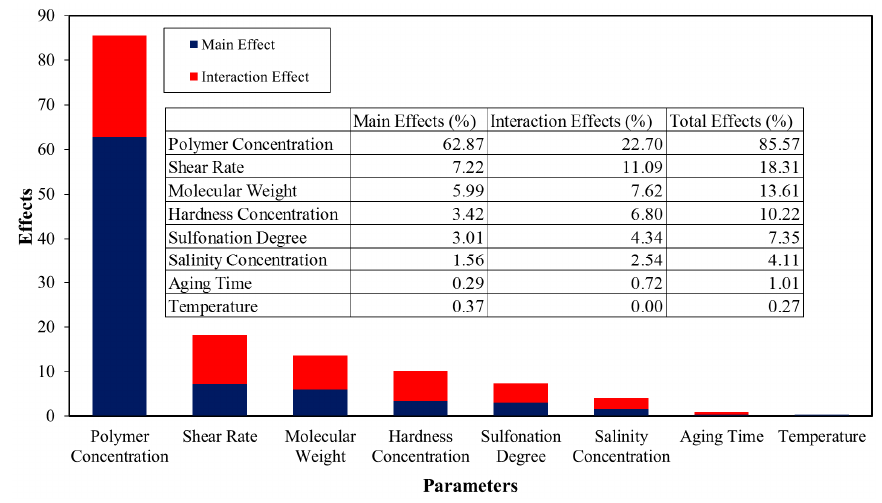
Figure 4. Sobol sensitivity analysis of eight input parameters of the viscosity model.